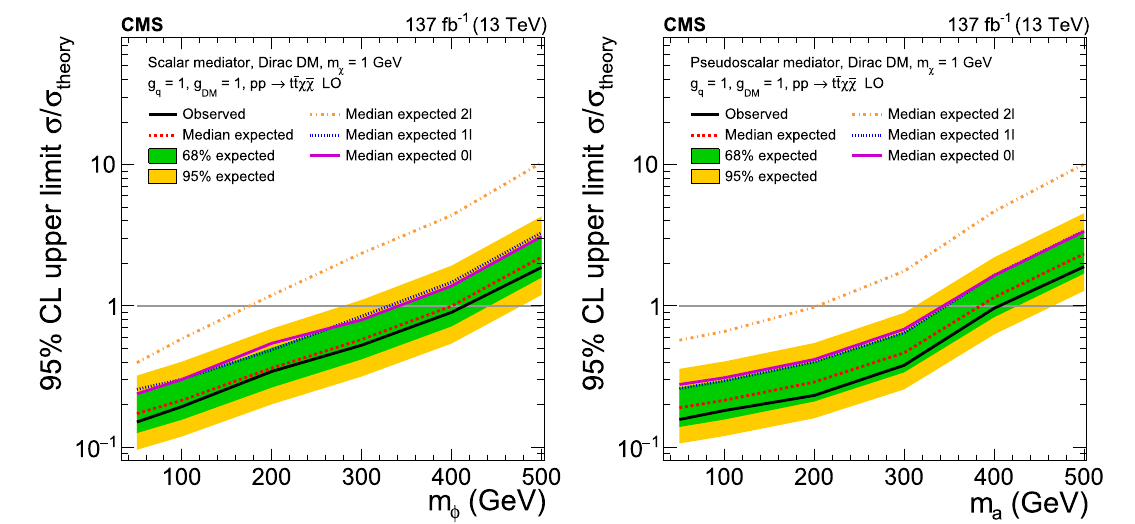
Fig. 10 The 95% CL expected (dashed line) and observed limits (solid line) on σ/σ theory for a fermionic DM particle with m χ = 1GeV, as a function of the mediator mass for a scalar (left) and pseudoscalar (right). The green and yellow bands represent the regions contain-